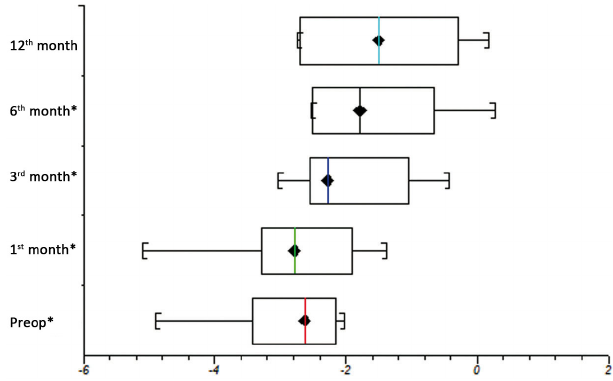
Fig. 2 - Evolution of median z-scores for weight/age (WAZ) in cardiac patients with WAZ in the pre-operative period which was below the normal developmental pattern. Analysis of variance with P=0.002. (*) The WAZ was significantly lower when compared with the general population’s in the preoperative period, in the first, third and sixth months